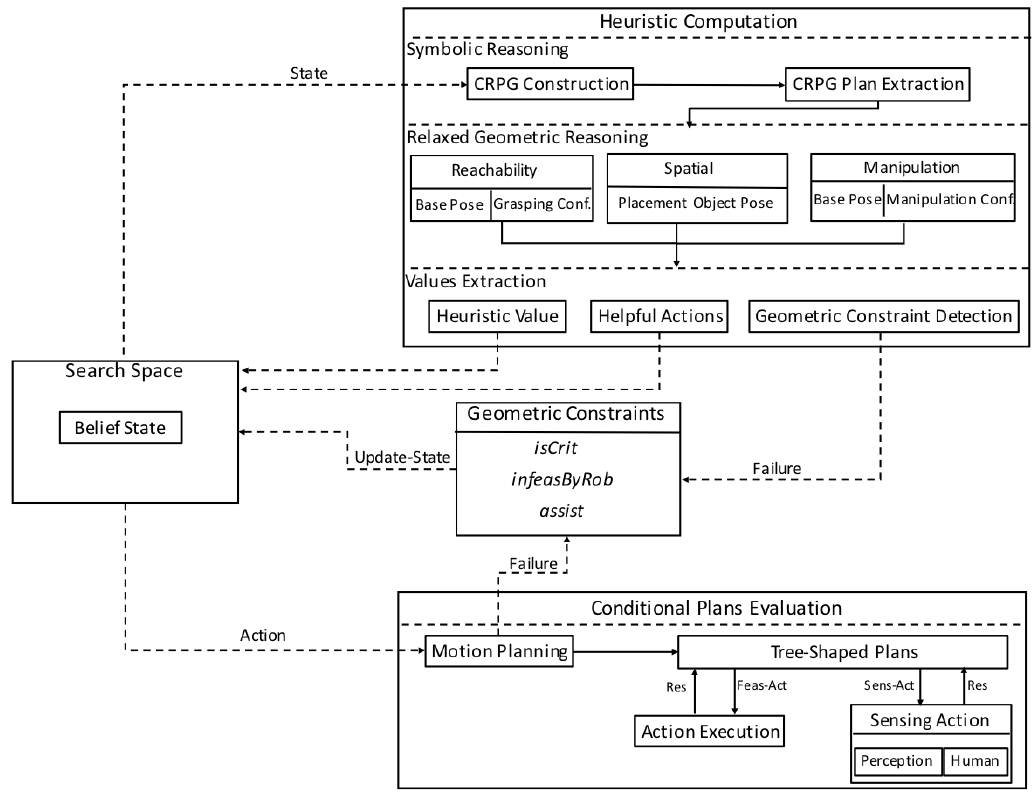
Figure 1. The proposed system overview of contingent task and motion planning using the extended version of Contingent-FF